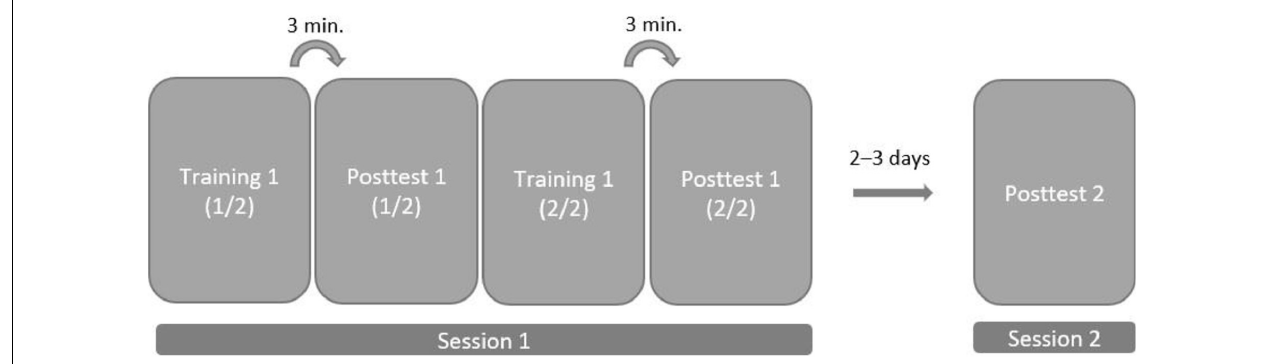
FIGURE 4 | The study design: In the first session, the story was split into two parts. Each training part was followed by a posttest that was administered after a 3-minute delay. Posttest 2 took place during the second session.